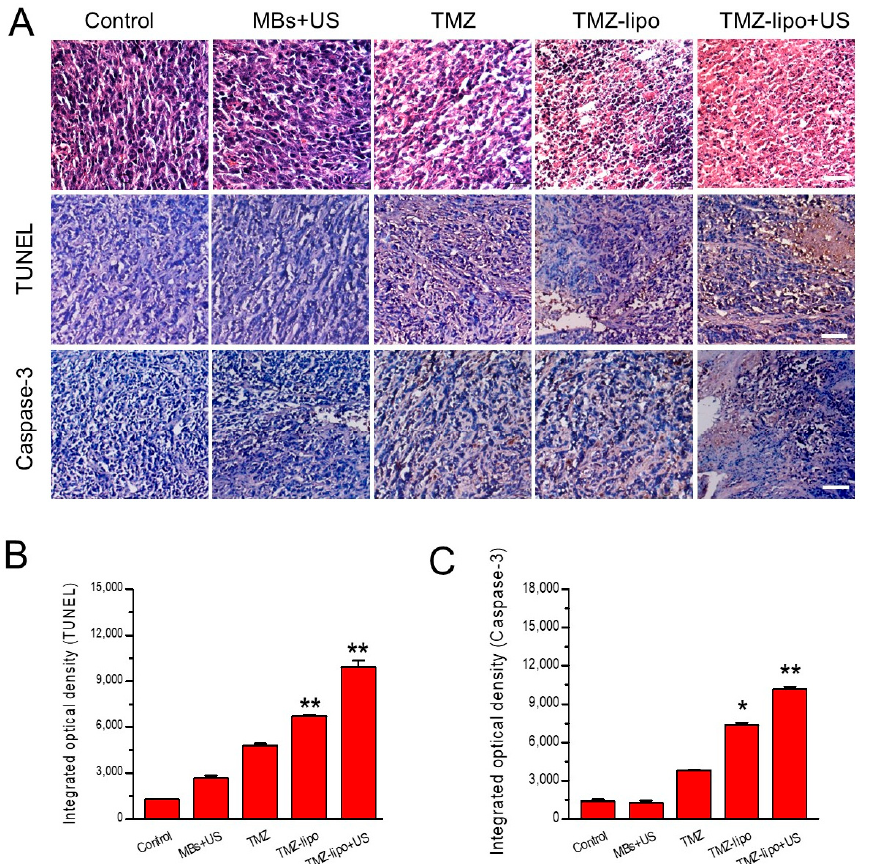
Figure 7. The detection of TUNEL and caspase-3. ( A ) H&E, TUNEL staining, and caspase-3 levels of brain tumors were analyzed. Scale bar = 100 µ m. ( B ) Quantitative analysis of TUNEL-positivity levels by mean optical densities. ( C ) Quantitative analysis of caspase 3-positivity levels by mean optical densities. * p < 0.05, ** p < 0.01.